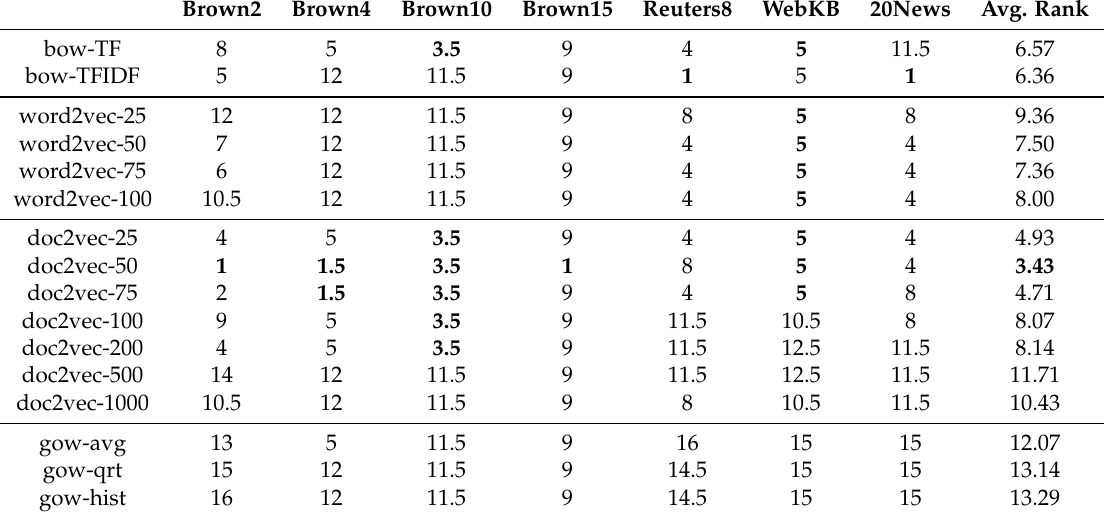
Table 5. Multi-objective ranking of the 16 variants of the three document representation models by the document classification task with respect to AUROC. The last column reports the average rankings over the seven tasks. The top-ranked models in each column are shown in